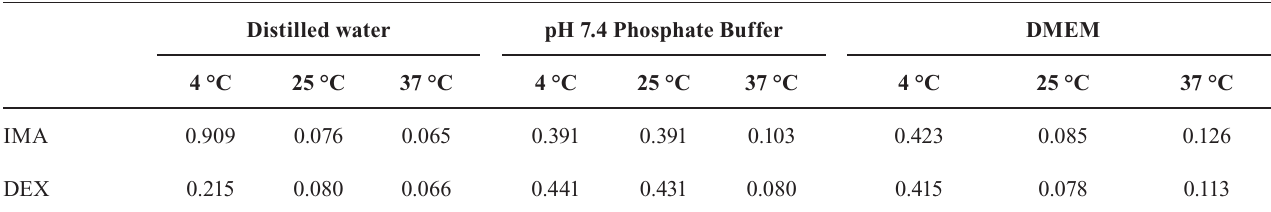
TABLE VII - P-values of remained DEX and IMA in solutions for robustness